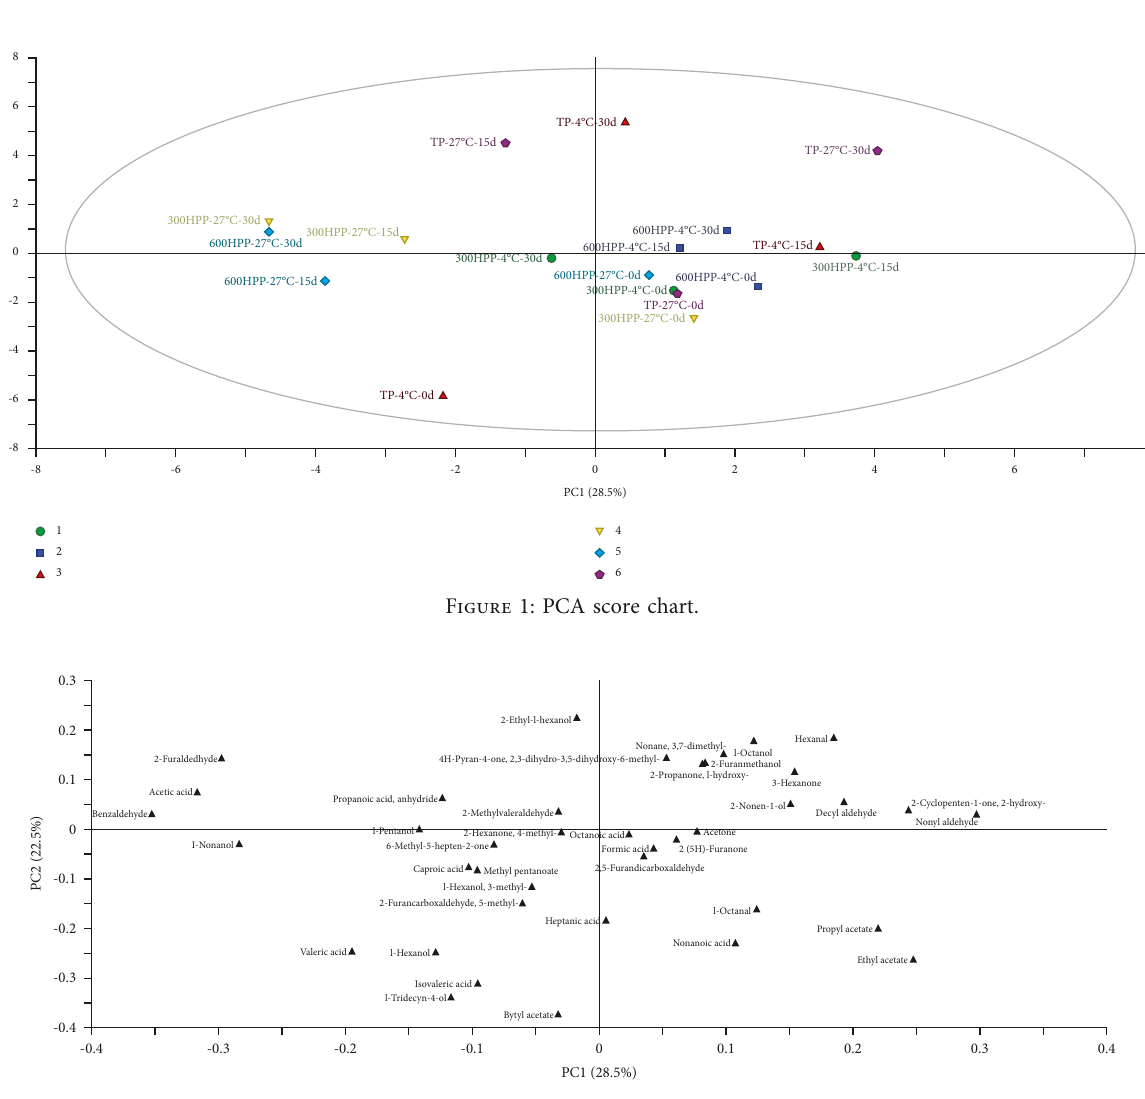
Figure 1: PCA score